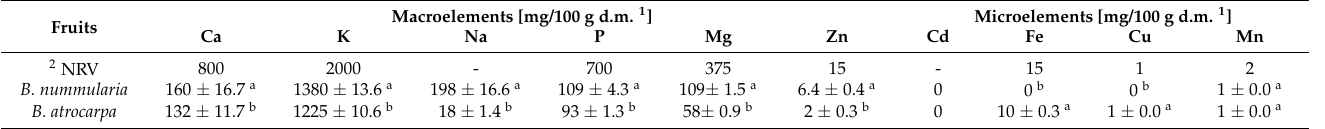
Table 2. The contents of elements in the fruits of two Berberis